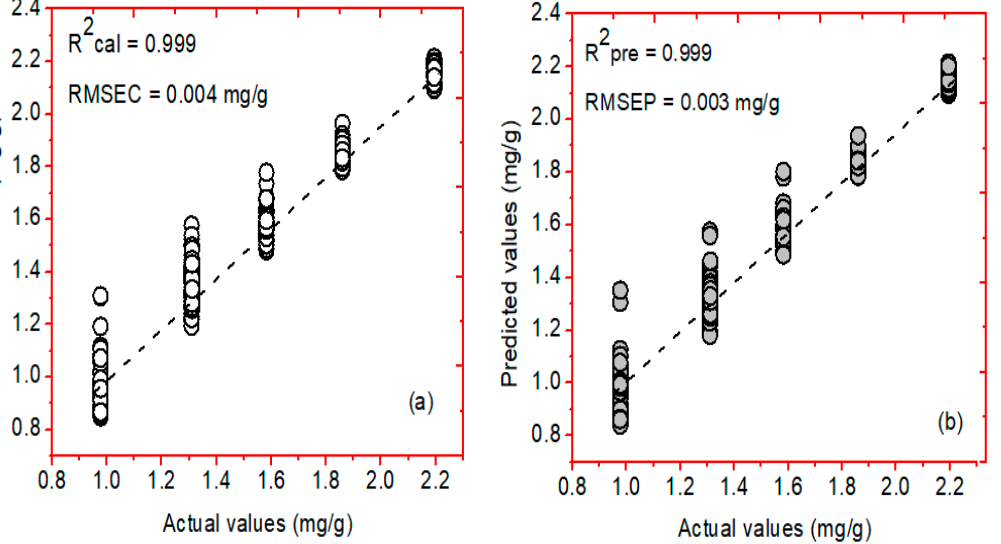
Figure 12. PCR graphs of actual and predicted concentration values for the phenolic compounds in